Question: Describe this figure in one sentence.
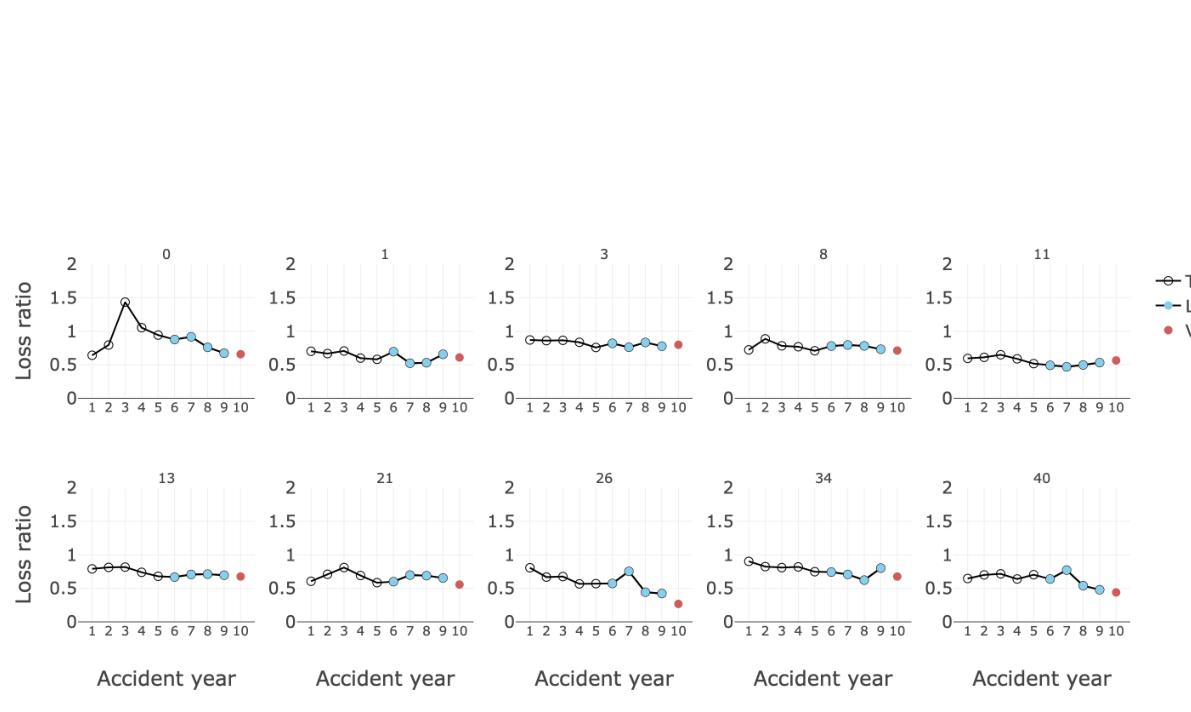
Answer: Ten randomly selected programs of 50 used for the forecasting example. Each program has 10 close-to-ultimate incurred loss ratios (circles), developed to 10 years. Each candidate model is fit to all 50 programs through year 9 and predictions are validated at year 10 (red points). Leave-future-out cross-validation is used to predict years 6 through 9 (blue points) to create a test-set of data to train the blending models.